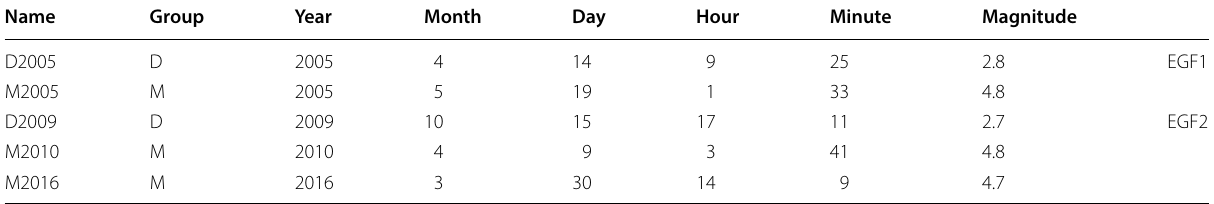
Table 1 Kushiro‑Oki